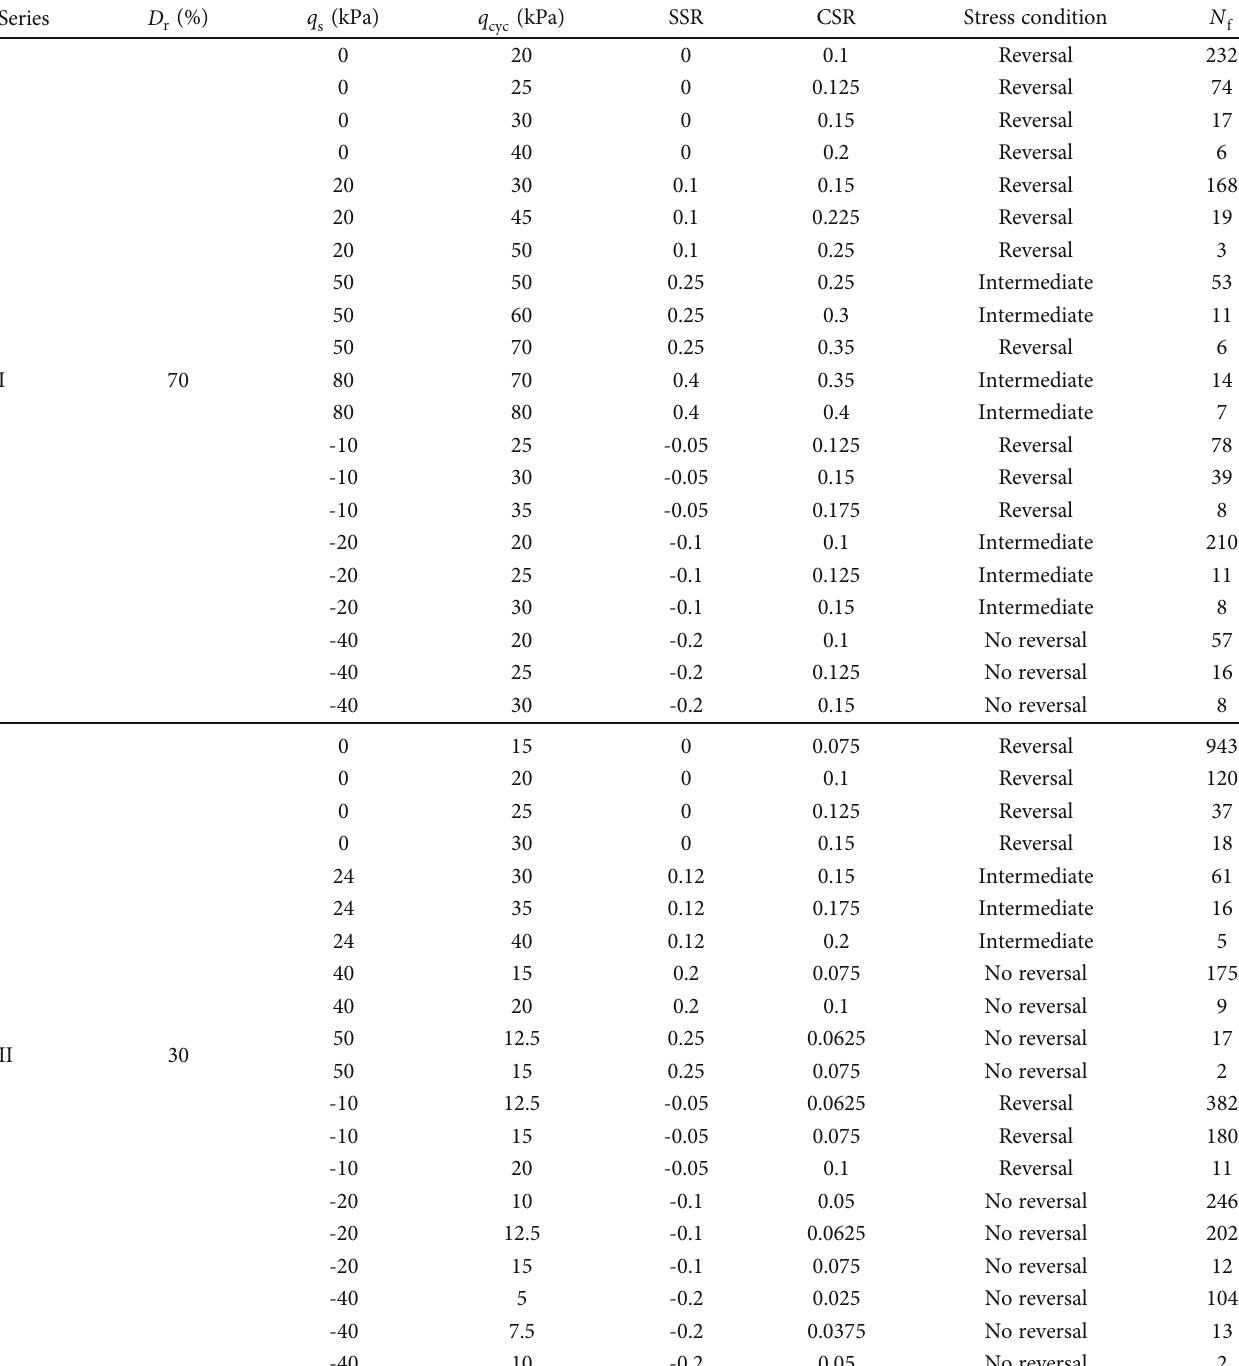
Table 2: Summary of undrained cyclic triaxial